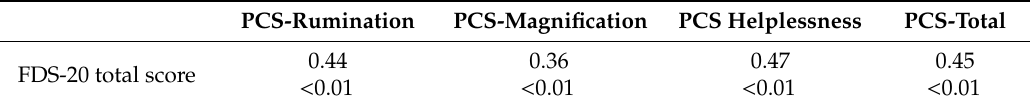
Table2. Correlationalmatrix(Kendall’stau, p )betweentheFragebogenzudissoziativenSymptomern-20 (FDS-20) total score and the Pain Catastrophizing Scale (PCS) total and subscale scores. PCS-Rumination PCS-Magnification PCS Helplessness PCS-Total 0.44 0.36 FDS-20 total score < 0.01 <